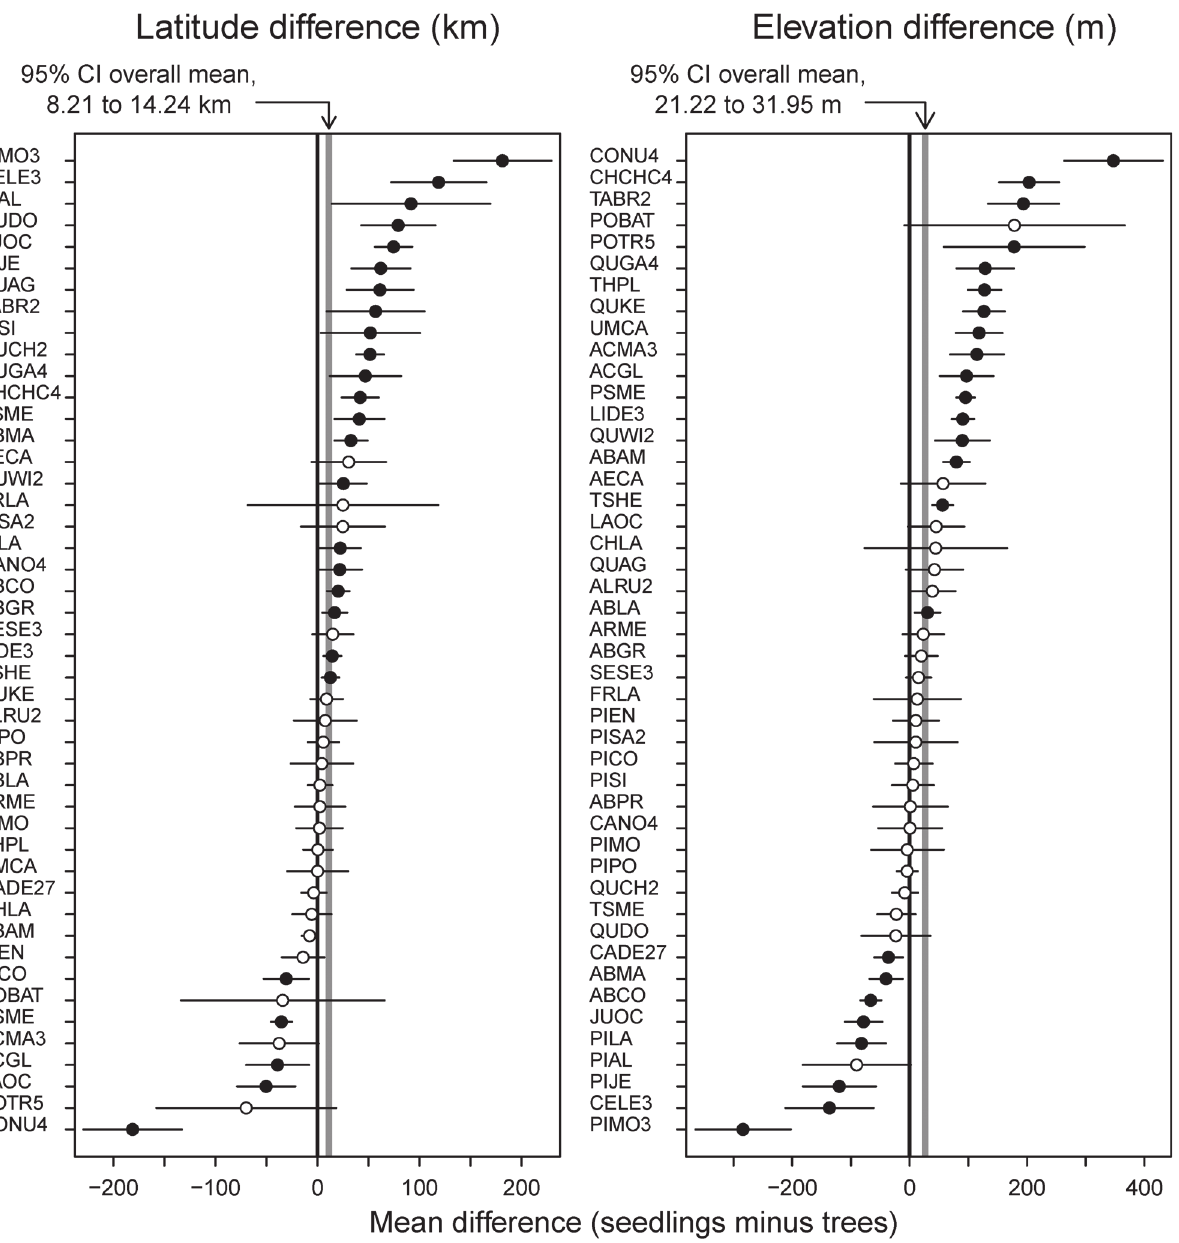
Fig 2. Difference between the mean latitude and elevation of the range of seedlings and mature trees. A positive number indicates that the mean of the seedling range is higher than or north of that of trees. The circles represent the estimated difference for each species and the horizontal lines represent 95% confidence intervals for the difference. Solid circles indicate that the 95% CI does not include 0 (difference significant at the 0.05 level), open circles indicate that the 95% CI includes 0. The gray band is a 95% confidence interval for the overall mean difference, across all species. Species name codes listed